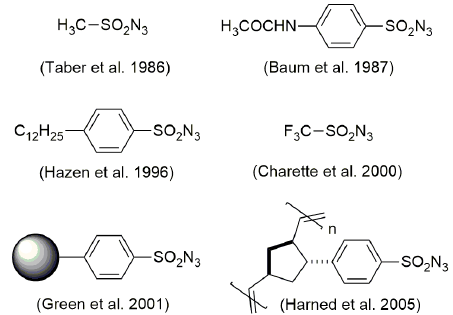
Figure 23 - Sulfonyl azide derivatives that have been used as an alternative to tosyl azide.